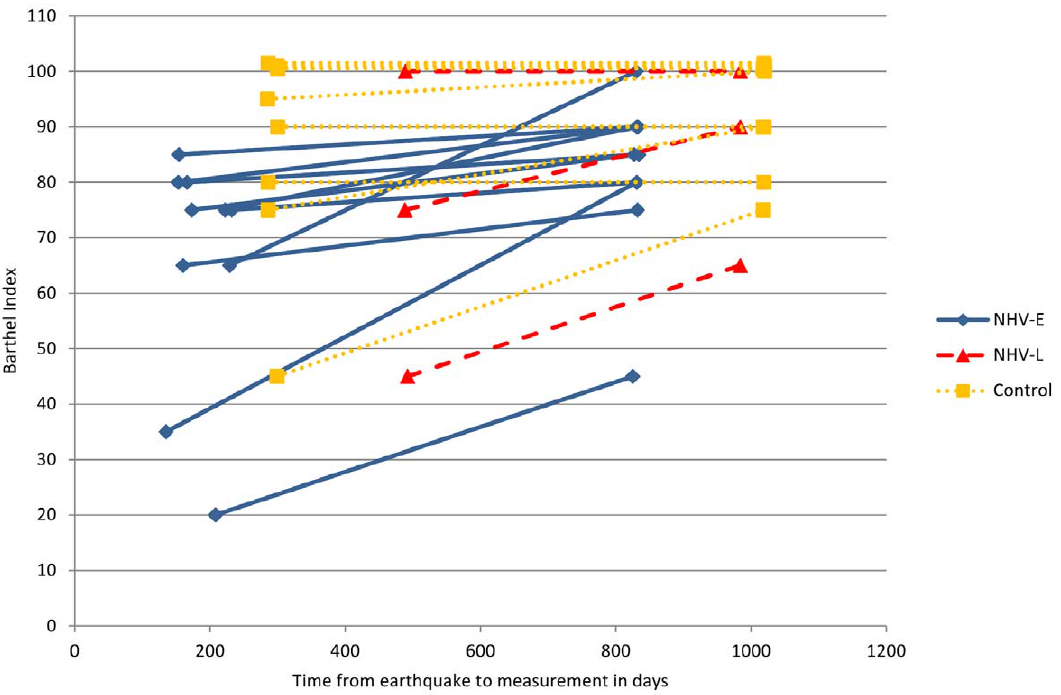
Figure 3. Ceiling effect of the Barthel Index in amputees (three patients from the control group and one from NHV-L begin with a censored score at baseline). Observations for one patient at different time points are connected by lines.